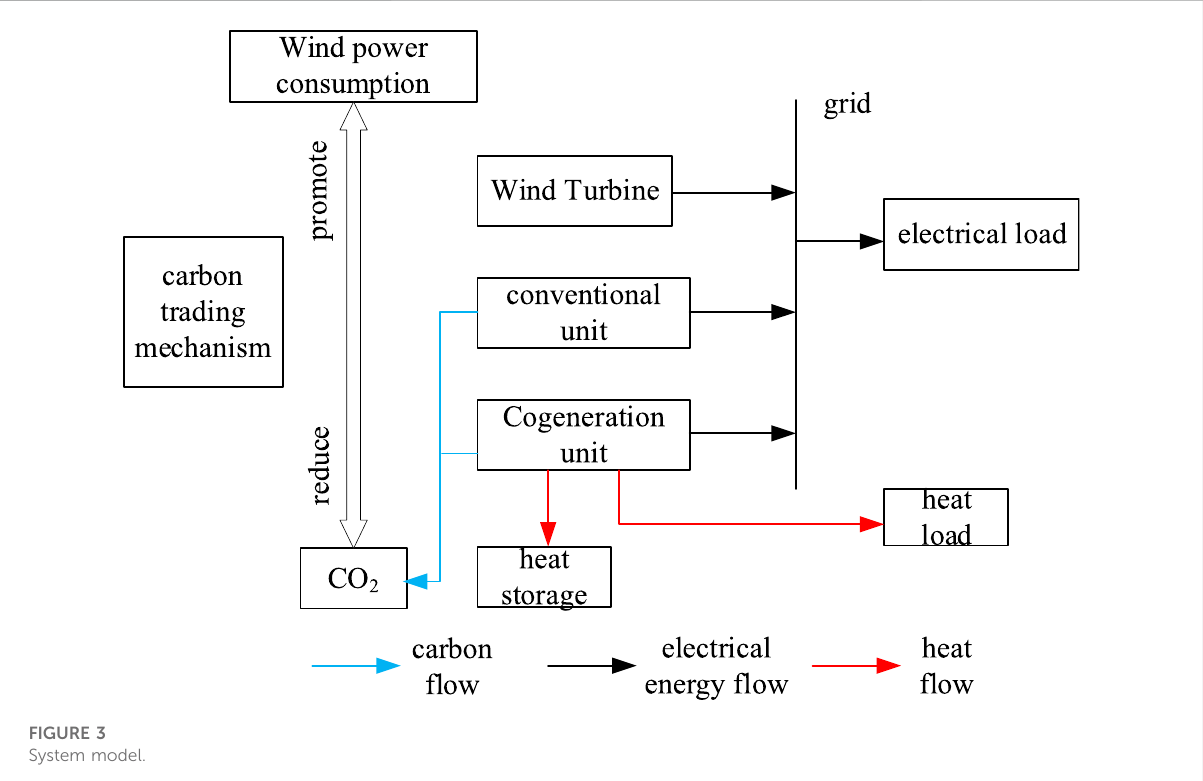
FIGURE 3 System